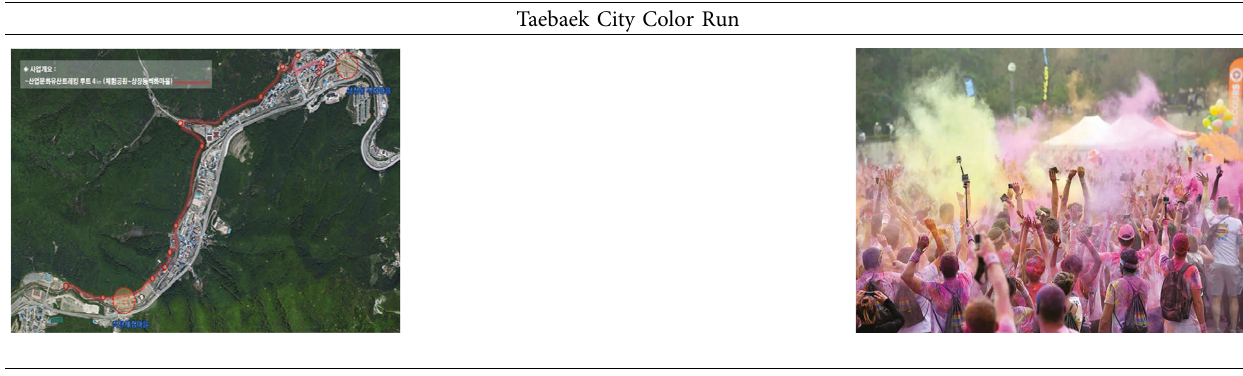
Table 12: Urban regeneration strategies for Taebaek city as a leisure and sports